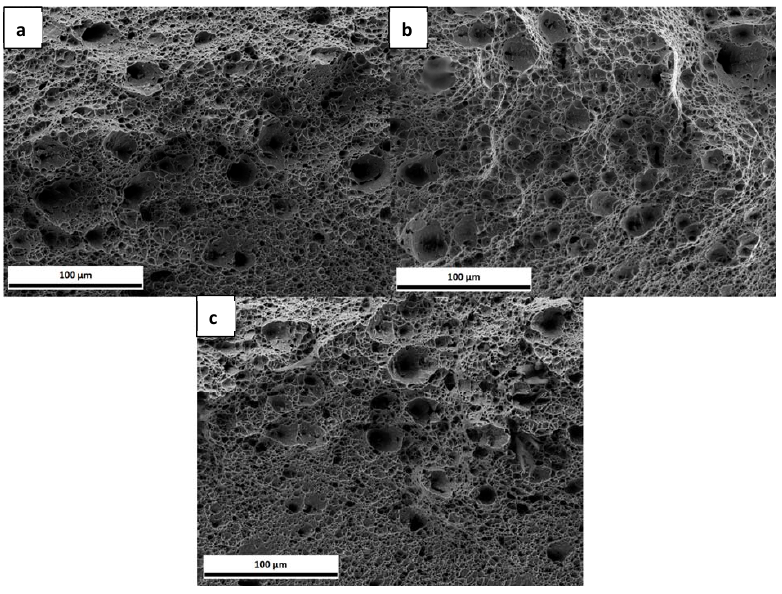
Figure 4. Fracture surfaces of complex phase (CP) steel tested with strain rates of ( a ) 3 × 10 − 5 s − 1 ; ( b ) 1.5 × 10 − 4 s − 1 ; ( c ) 3 × 10 − 4 s − 1.